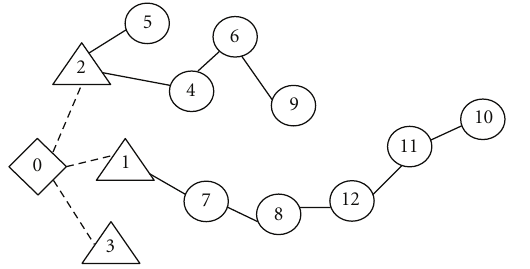
Figure 1: Electric distribution tree corresponding to code C = (4, 6, 2, 2, 4, 8, 7, 6, 11, 12).